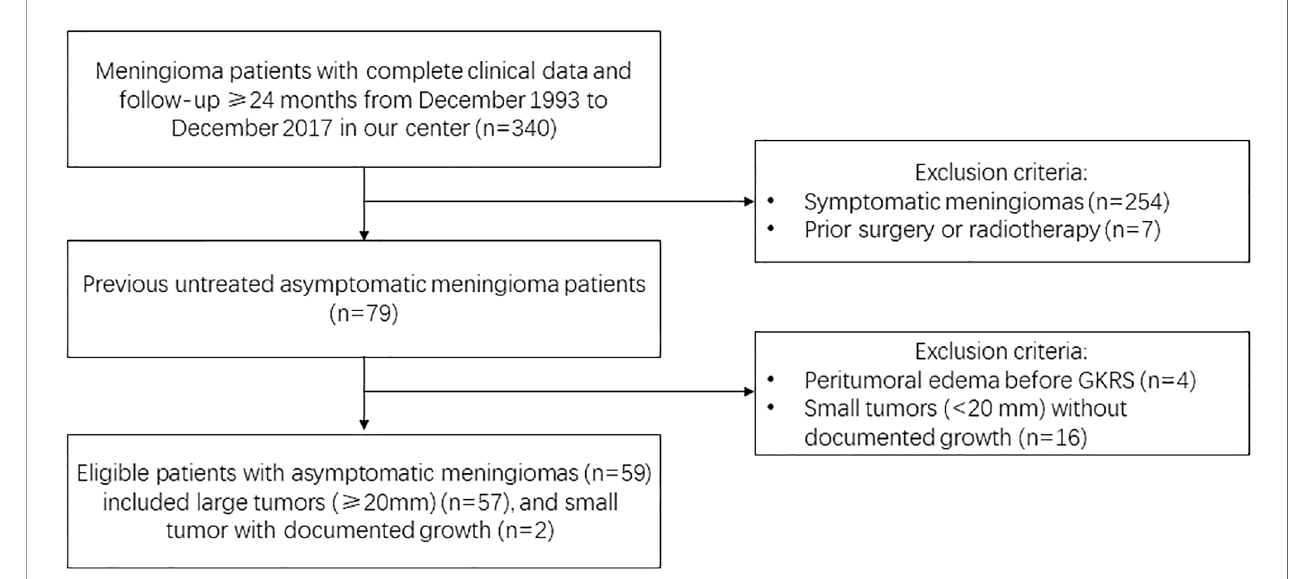
FIGURE 1 | Study design with fl ow chart and initial GKRS criteria for large ( ≥ 20 mm) or documented growth asymptomatic